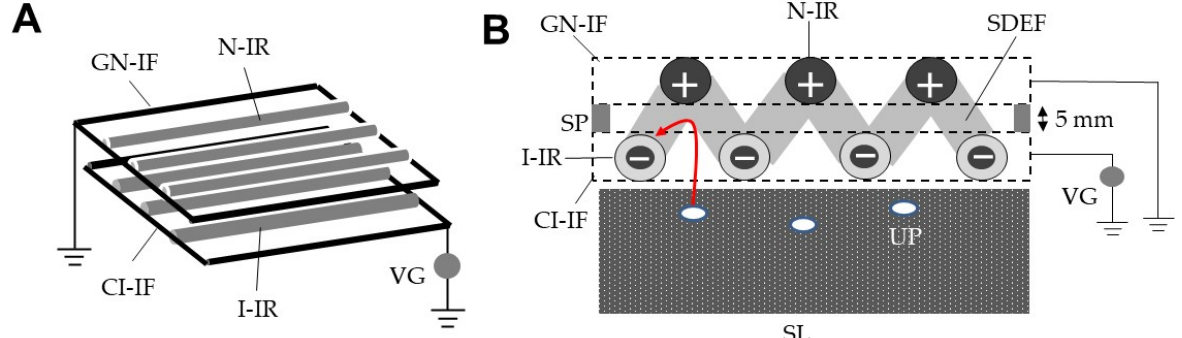
Figure 6. Diagram of an electrostatic covering (EC) to capture adult tomato leaf miner flies emerging from underground pupae ( A ) and an SDEF formed between negatively charged, insulated iron rods and grounded, non-insulated iron rods (cross-sectional view) ( B ). Red arrow indicates the path of a leaf miner that emerged from a pupa in a soil. GN-IF, grounded non-insulated iron frame; CI-IF, charged, insulated iron frame; N-IR, non-insulated iron rod; I-IR, insulated iron rod; VG, voltage generator; SDEF, single-charged dipolar electric field; SP, spacer, UP, underground pupa; SL, soil. [11].